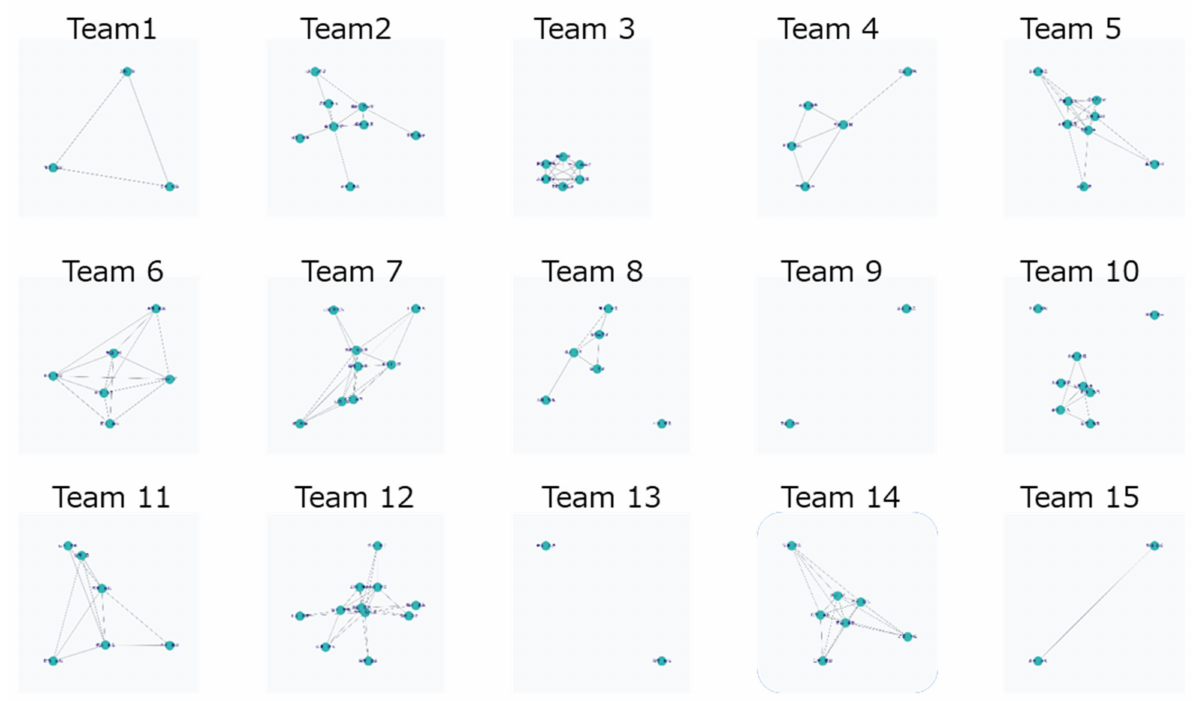
Figure 3. Gratitude network for each team. The 15 graphs in Figure 3 are classified into three different structure types: a dense network type, as in team 3; a sparse network type, as in team 4; an intermediate network type, as in team 5. To distinguish between network types, we considered the indicators of these